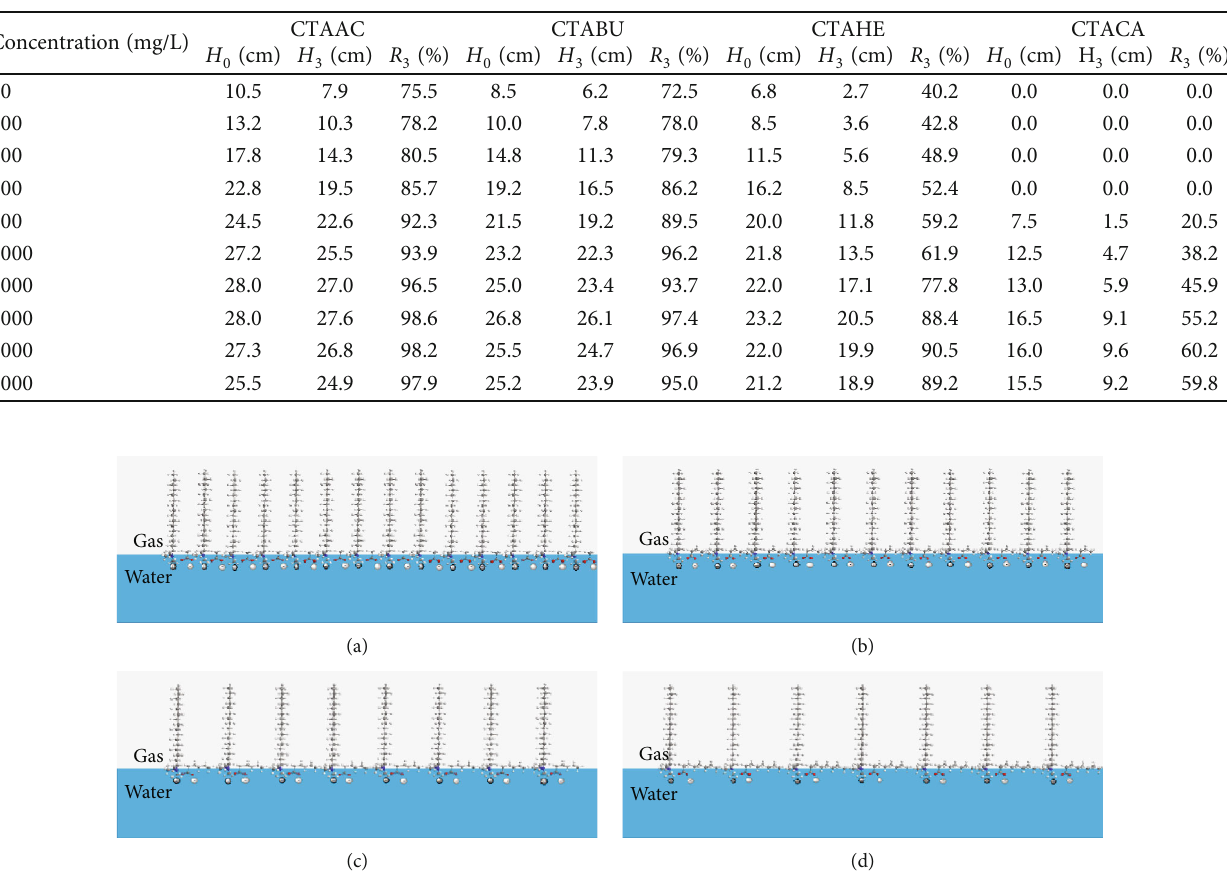
Figure 3: Schematic representation of di ff erent surfactants: (a) CTAAC, (b) CTABU, (c) CTAHE, and (d)